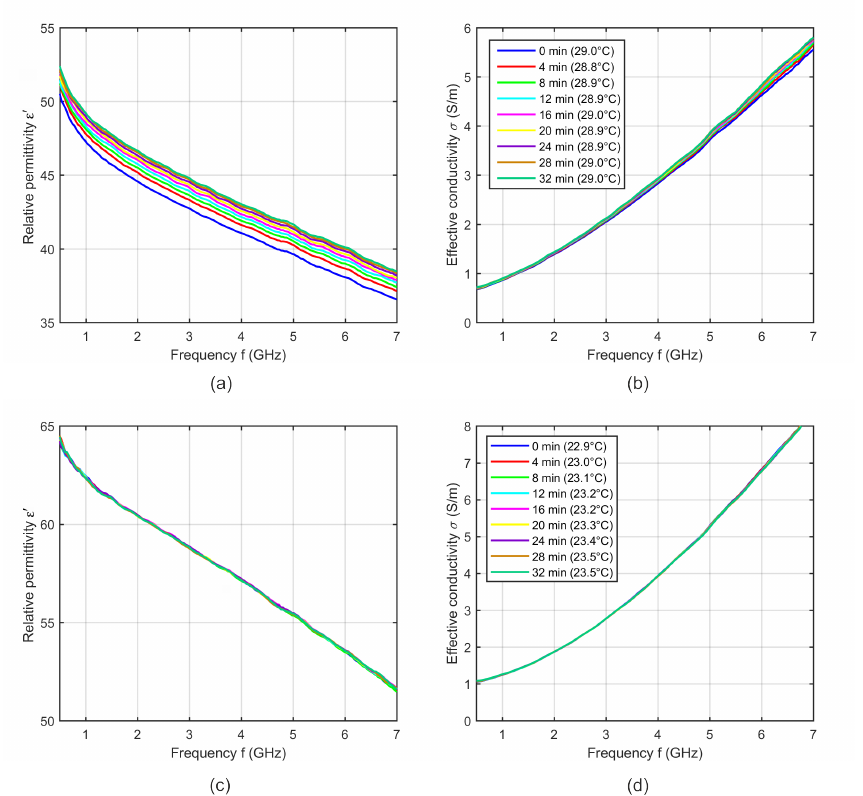
Figure 4. ( a ) Relative permittivity and ( b ) effective conductivity of one porcine liver sample as